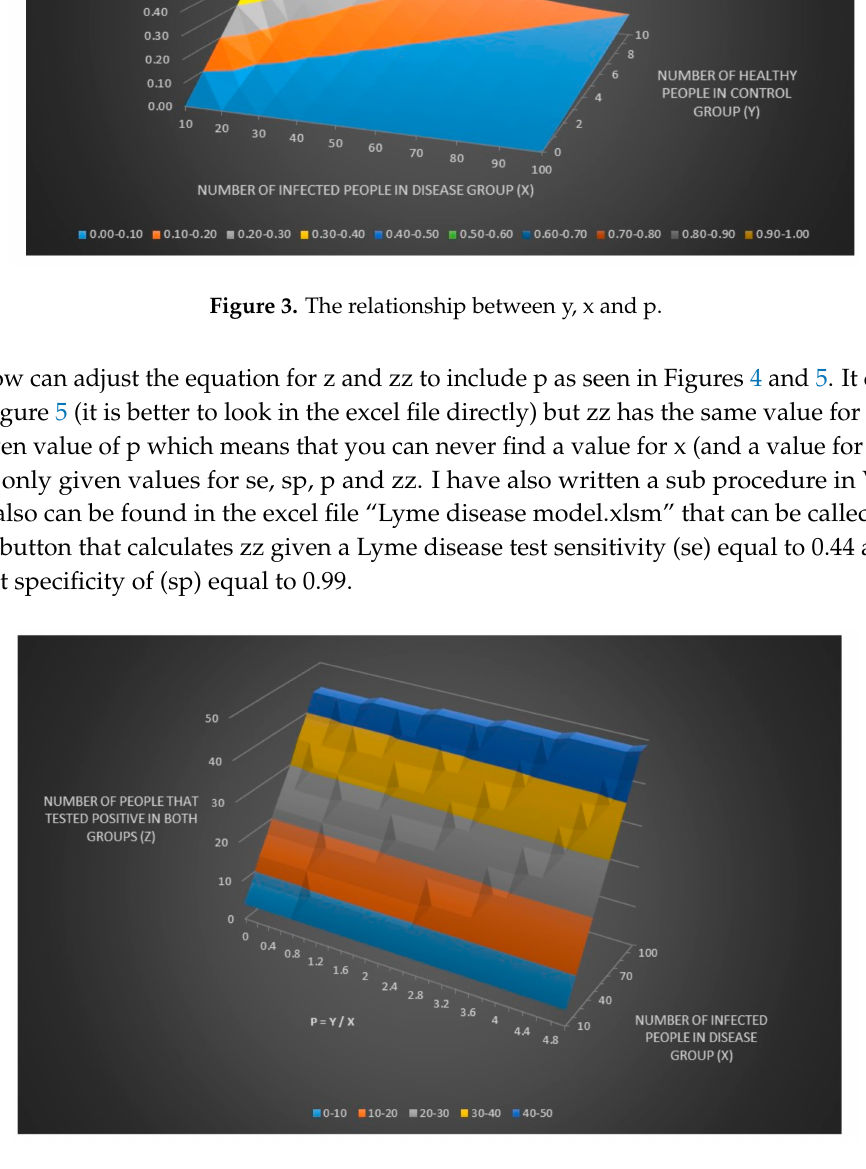
Figure 4. The number of people that tested positive in both groups (z) adjusted for the relationship between y and x